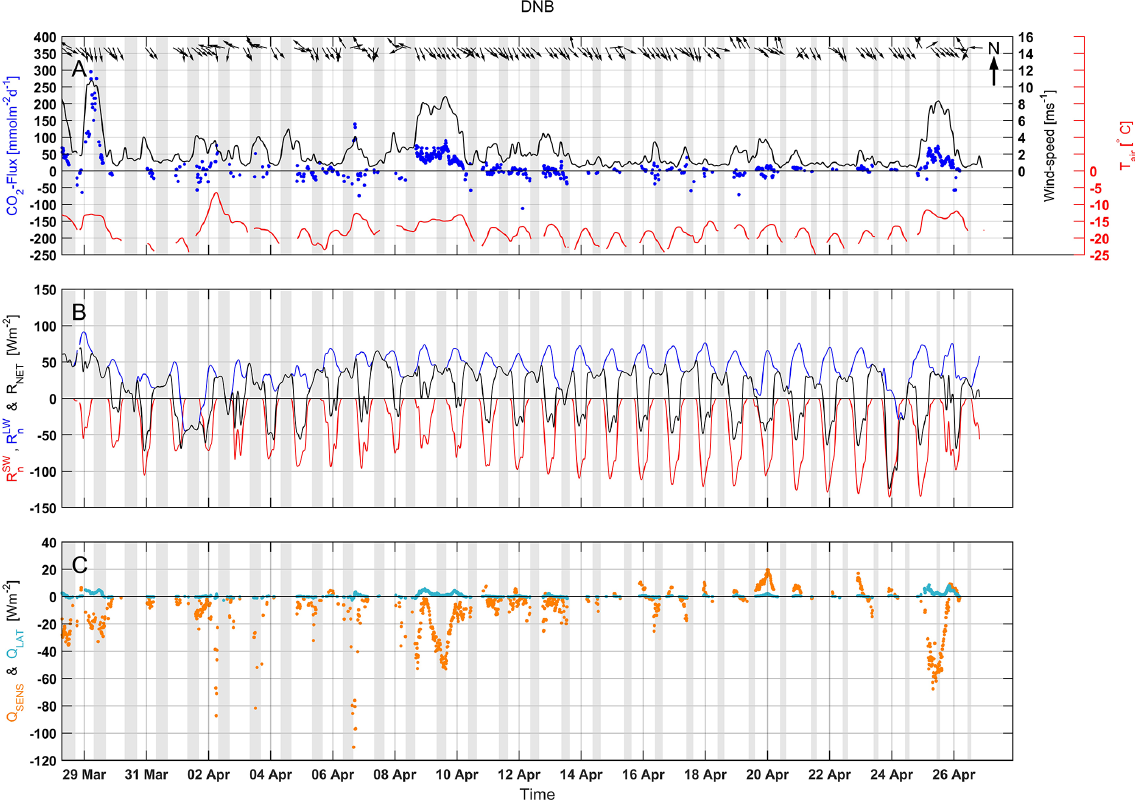
Figure 4. DNB time series shown as for Fig. 2, but without green bars indicating instrument status in (a)